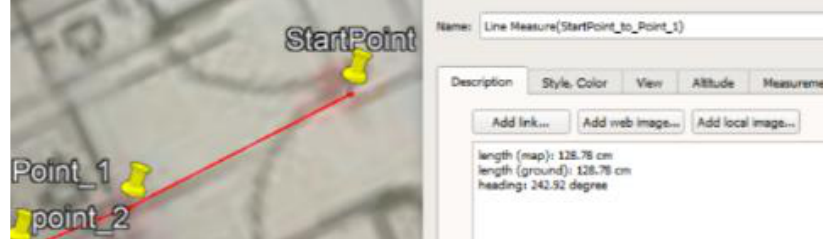
Figure 28. Length and heading to the first point.